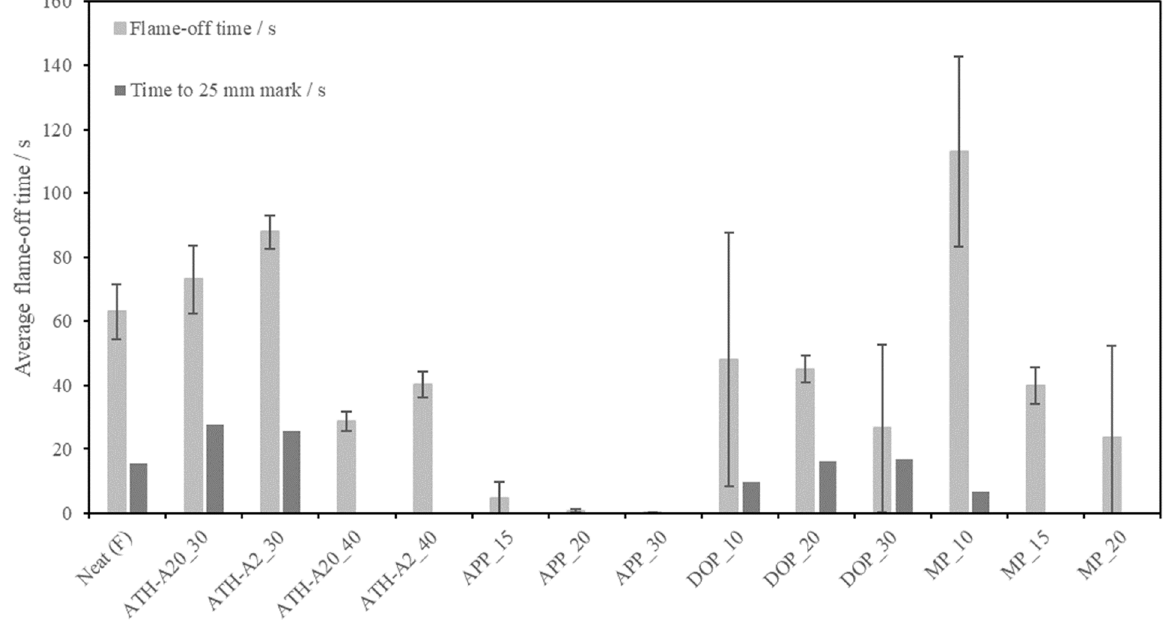
Figure 4. Average flame-off time of flame retardant modified EN/B-IPDA foam specimens ref. to UL94 Horizontal Burn (from left to right: neat, ATH, APP, DOPO, MP); specimens marked with (F) failed the UL94 HB criteria.